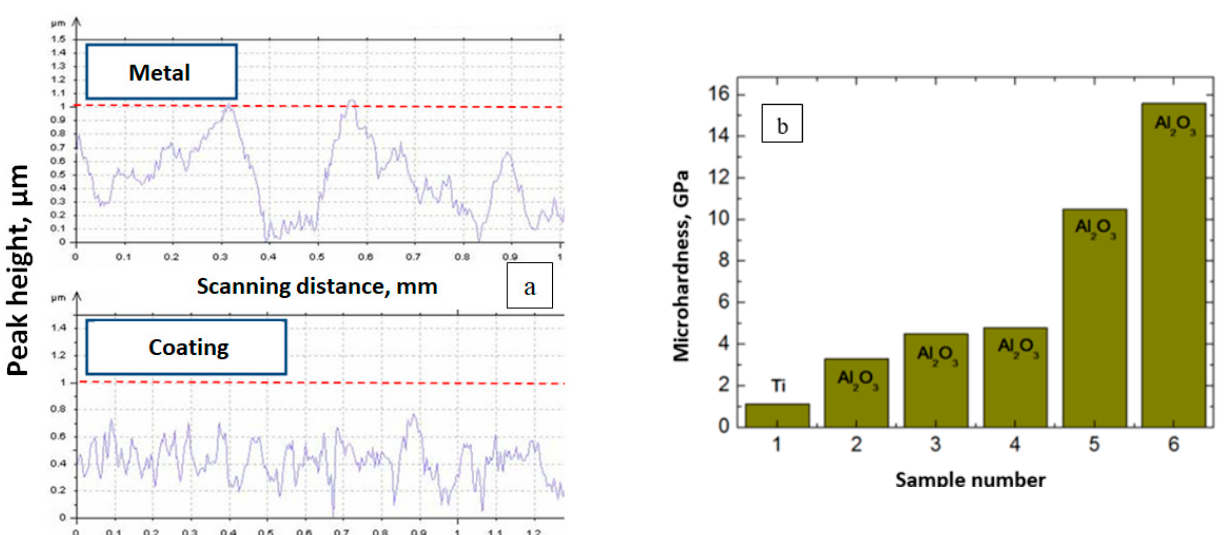
Figure 27. Surface profile of a ceramic-based coating on titanium: ( a )—original and coated samples; ( b ) — micro-hardness of the original titanium sample and with the deposited Al 2 O 3 coatings of different compositions [135].